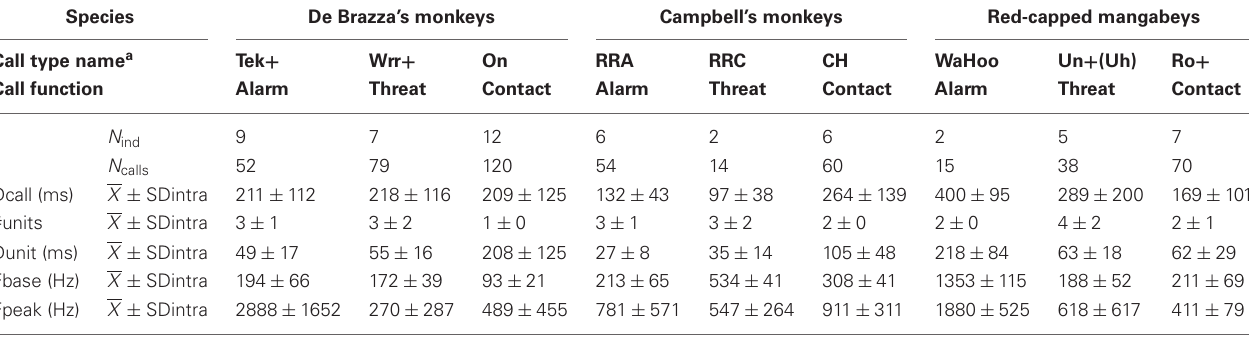
Table 2 | Call type characteristics and sample sizes. Species De Brazza’s